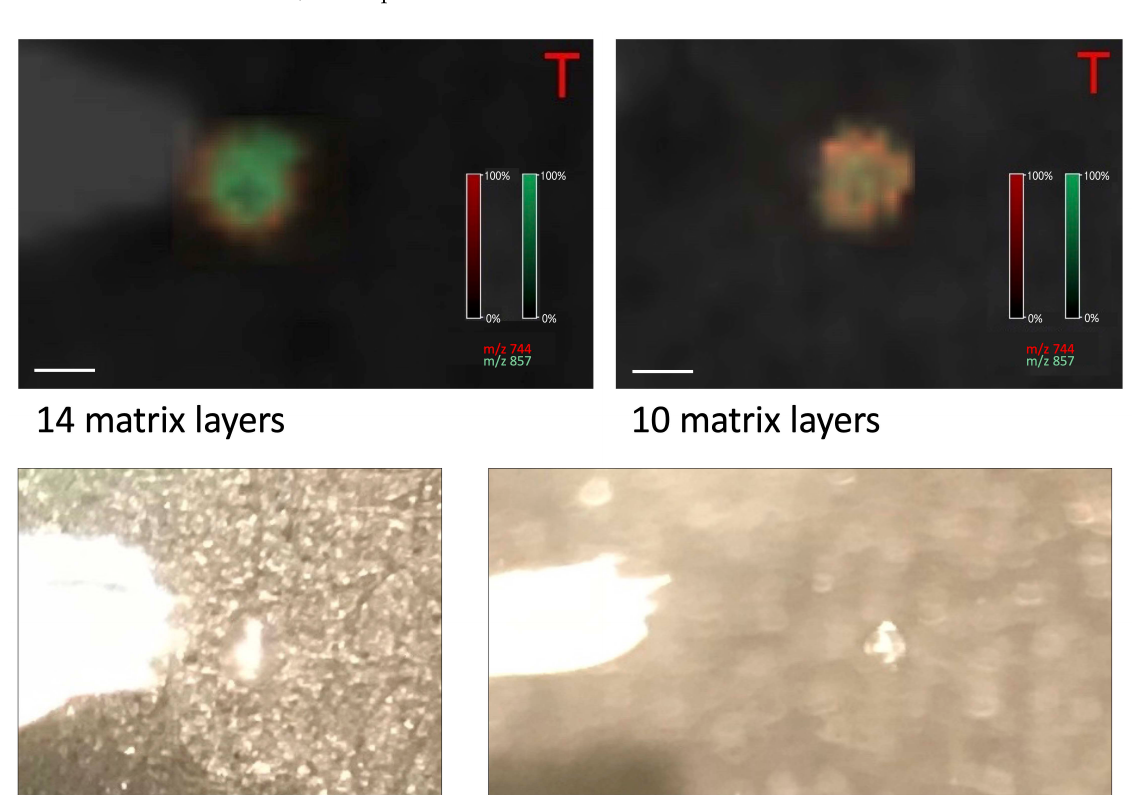
Figure 8. The picture of the oocytes obtained after covering them with different number of the matrix layers—negative ionization mode ( m / z 744 and 857), size bar: 200 µ m. Below it is presented the microscopic image of